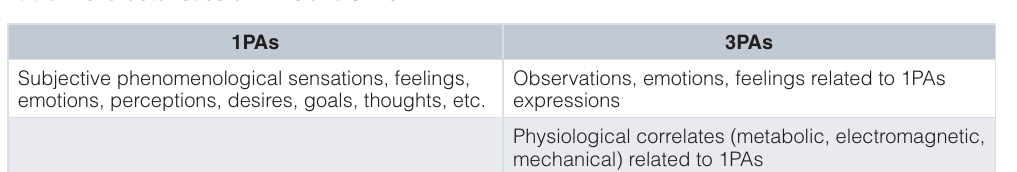
Table 1. characteristics of 1PAs and